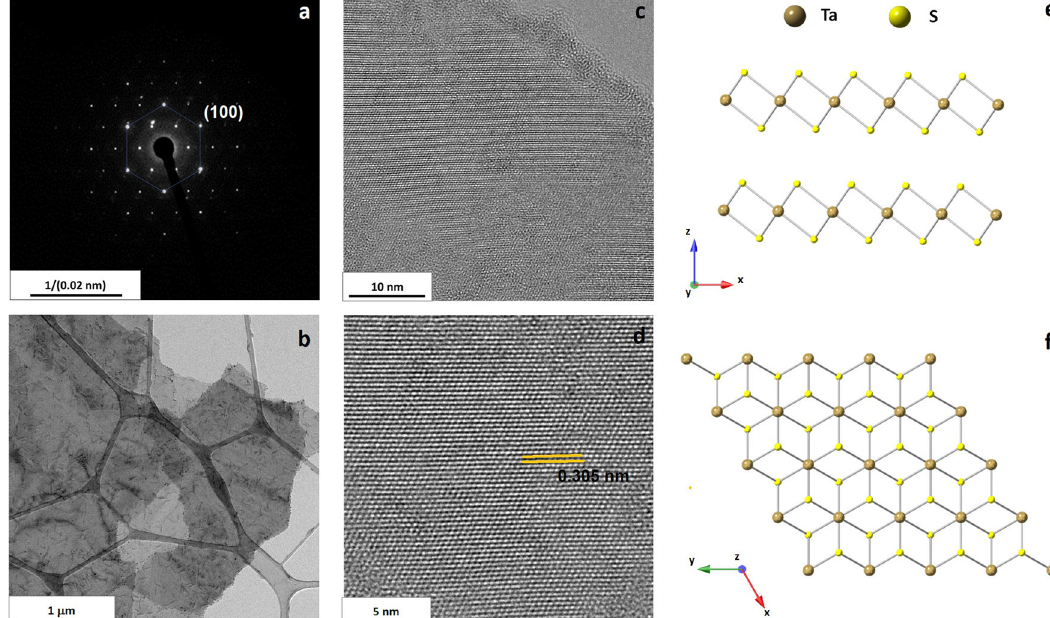
Fig. 3 SAED and TEM analysis of electrochemically exfoliated TaS 2 . a SAED pattern; b low-resolution TEM image; c, d high-resolution TEM images; schematic e side and f top views of the TaS 2 structure.